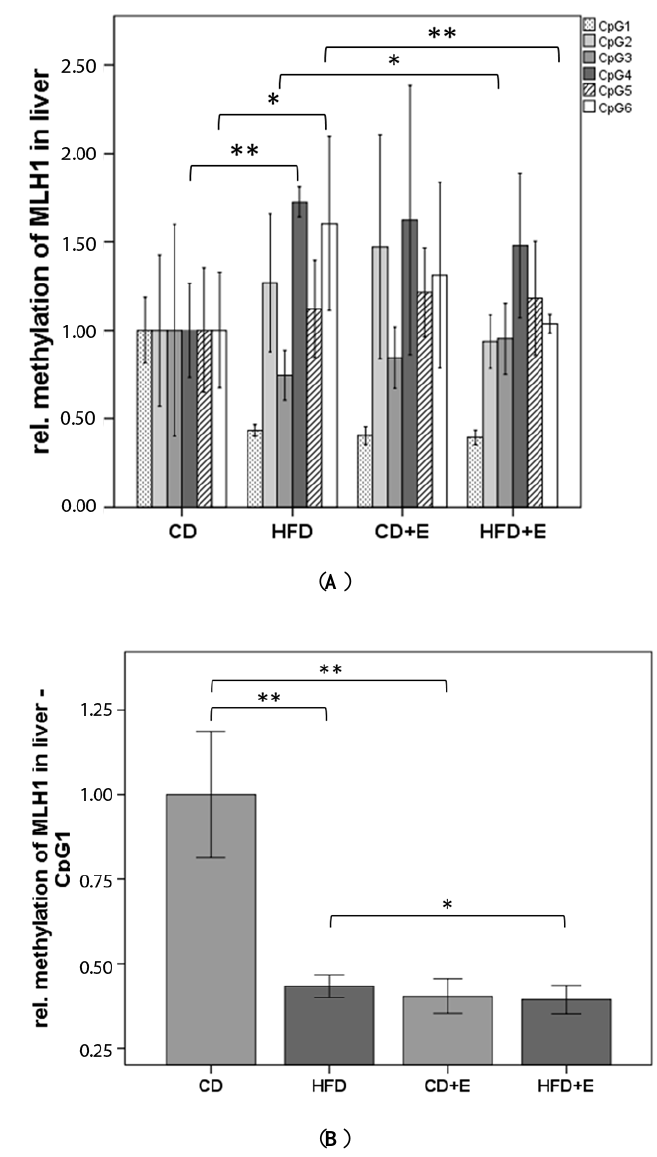
Figure 7. Relative CpG methylation status in promotor region of MLH1 in liver ( n = 15). Mean methylation data are shown for: MLH1 in the liver as an overview ( A ) and CpG 1 ( B ). All methylation data are shown relative to CD. The error bar represents a 95% confidence interval. (CD = control diet, HFD= high fat diet, CD + E = control diet plus vitamin E, HFD + E = high fat diet plus vitamin E, * p -value ≤ 0.05, ** p -value ≤